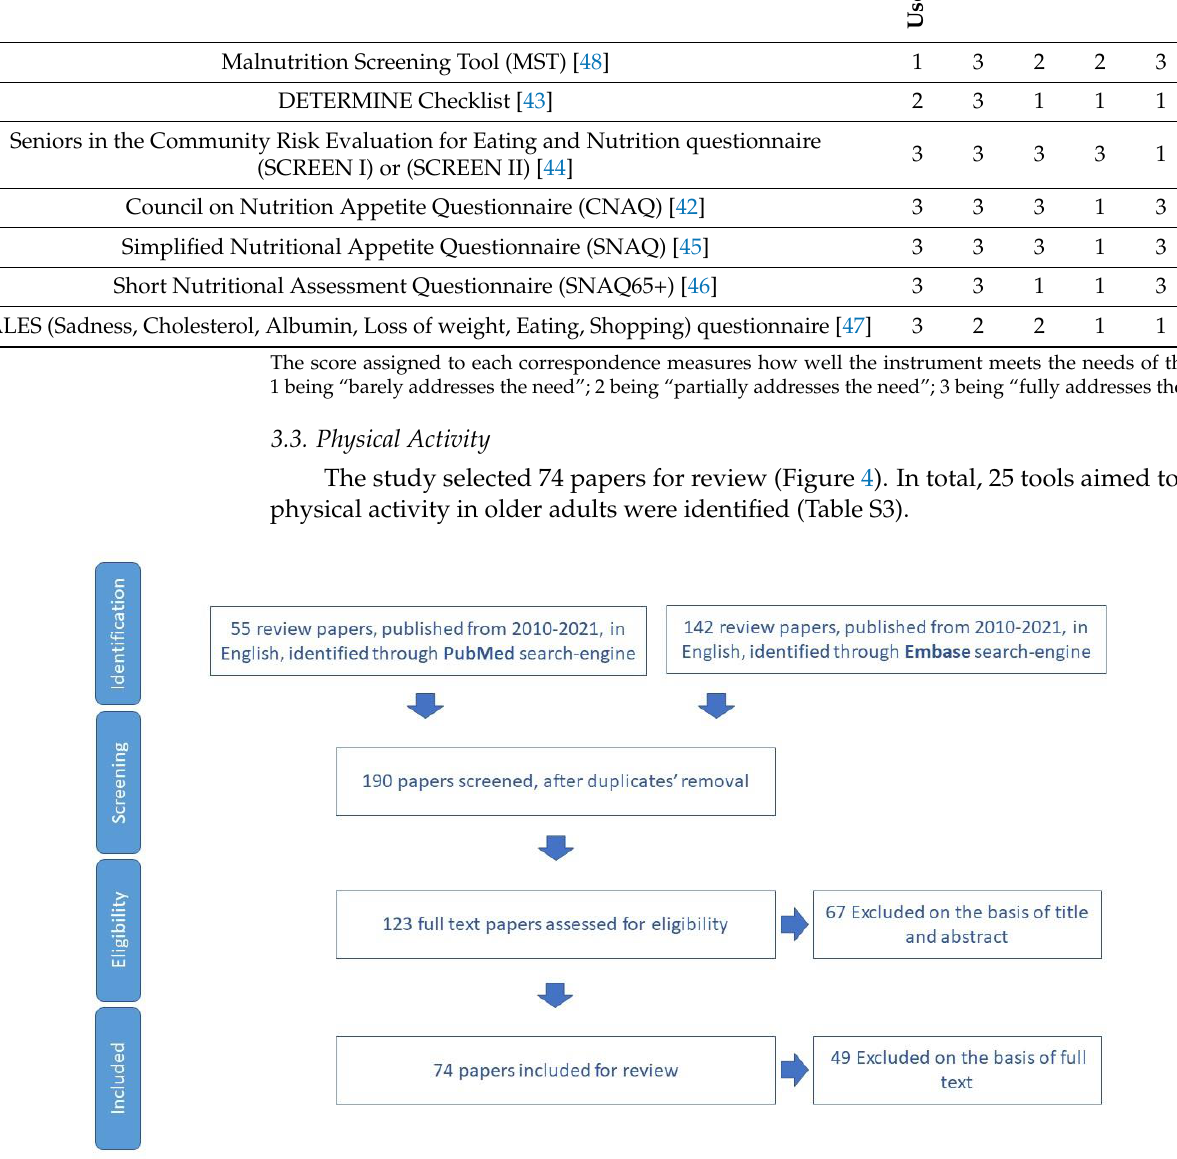
Figure 4. Process of study selection for physical activity domain.